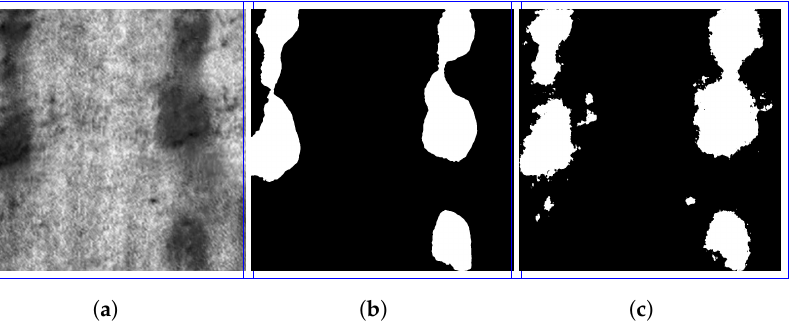
Figure 12. Results of defect segmentation by the PAN trained on the synthetically augmented NEU dataset. ( a ) StyleGAN2 generated synthetic image; ( b ) ground truth defect mask; and ( c ) predicted defect